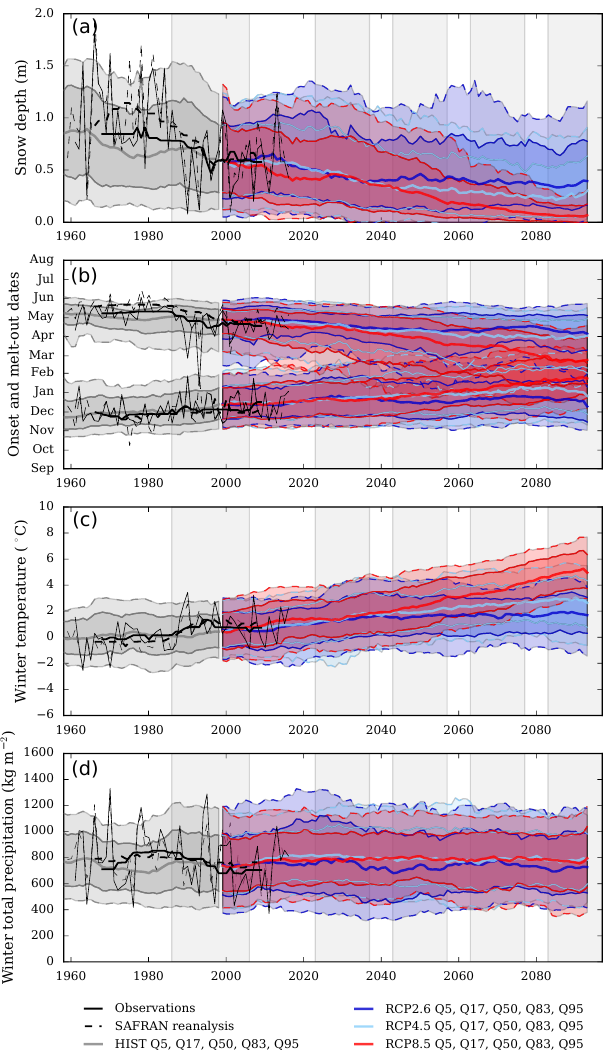
Figure 4. Quantile values (5, 17, 50, 83 and 95%) over 15-year windows of all GCM–RCM pairs (HIST, RCP2.6, RCP4.5 and RCP8.5), along with annual values of observations (1960–2016) and SAFRAN-Crocus runs (1958–2016) and their respective 15- year running medians (bold full and dotted lines, respectively), for (a) SD, (b) SOD and SMOD, (c) T , and (d) P . Light grey bars in- dicate the reference period 1986–2005 and the time slots used in Tables 2–4 and S1–S2.